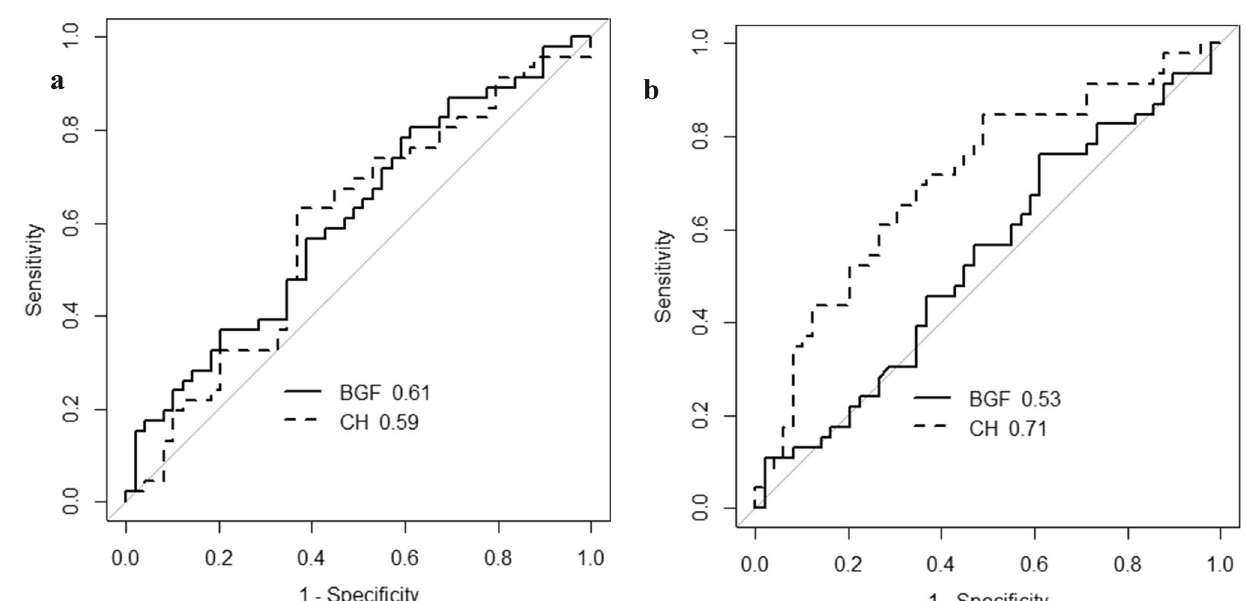
Figure 2. Receiver-operating curves to discriminate control and treatment-naïve POAG eyes ( a ) as well as control and treated POAG eyes ( b ) for CH and BGF. BGF: biomechanical glaucoma factor, CH: corneal